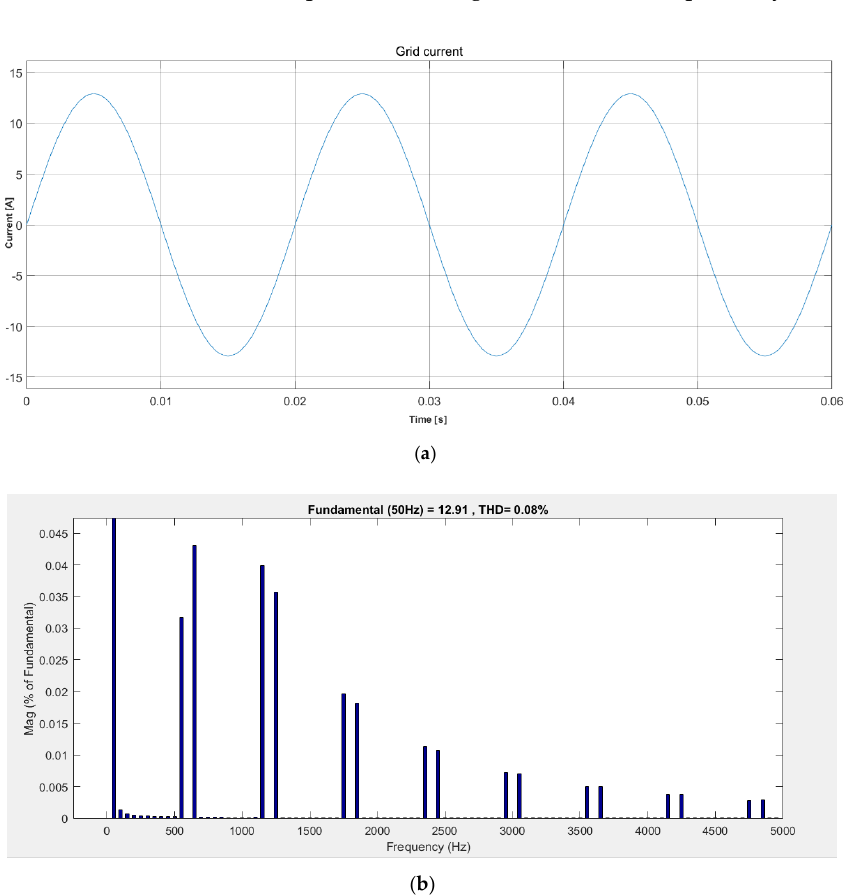
Figure 16. Grid current ( i L1 ) drawn by the rectifier with CM current modulator (based on an ideal current source) and CM 2 supporting system: ( a ) waveform, ( b ) spectral analysis.